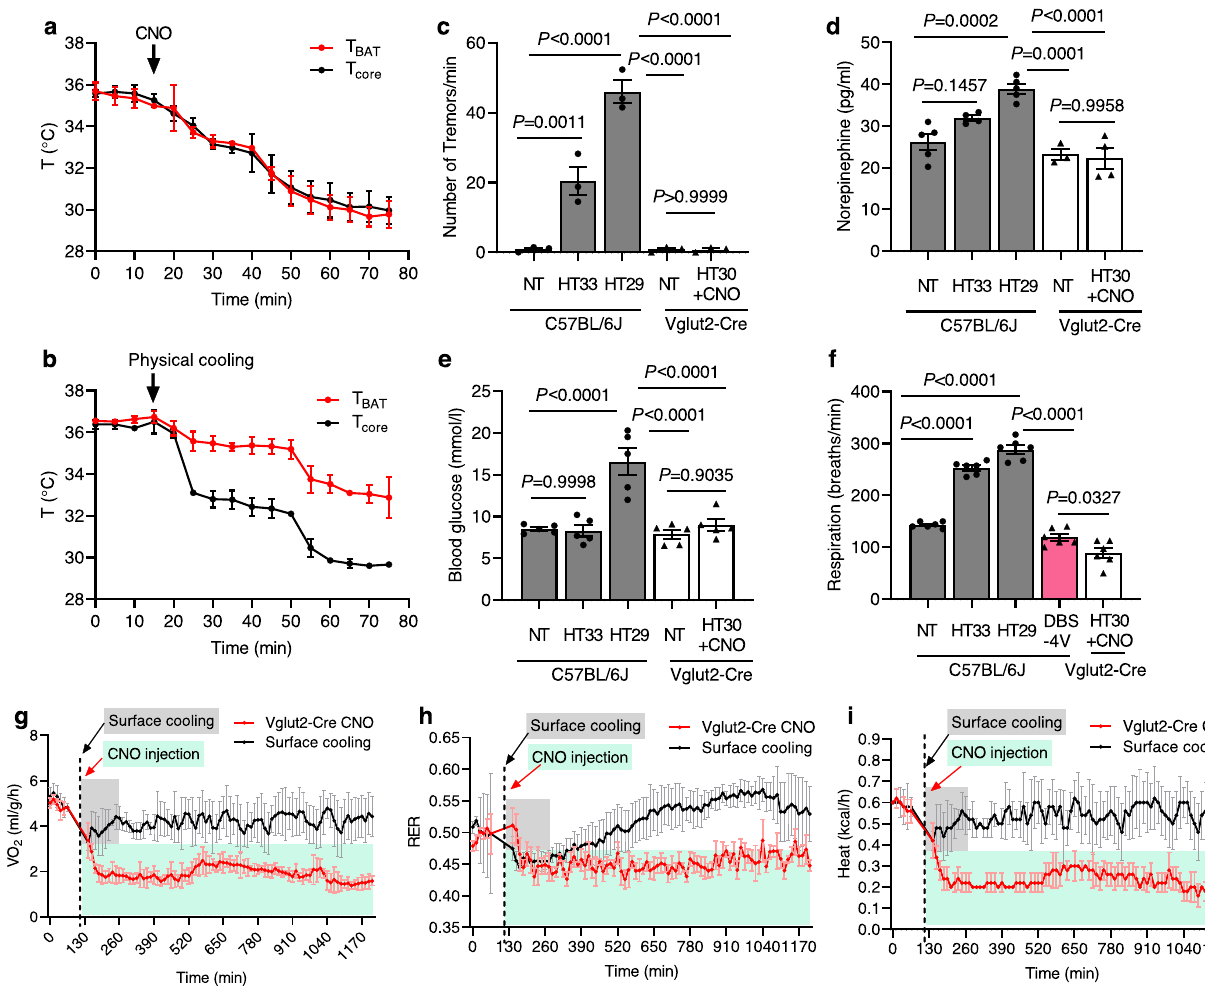
Fig. 2 | Physiological and metabolic changes during hypothermia evoked by chemogeneticsandsurfacecooling.a , b The T BAT andcorresponding T core during hypothermia were measured in mice ( n =3 mice). Hypothermia was produced in Vglut2-Cre mice injected with Gq-DREADD-AAV for 3 weeks and followed by CNO i.p.injection( a ).HypothermiawasinducedinC57BL/6Jmicebysurfacecooling( b ). c The numbersof tremorswererecorded(F (1, 12) =155.20, P <0.0001). d The blood levelsof norepinephrine (F (4, 25) =157.1, P <0.0001) and ( e ) glucose (F (4,20)